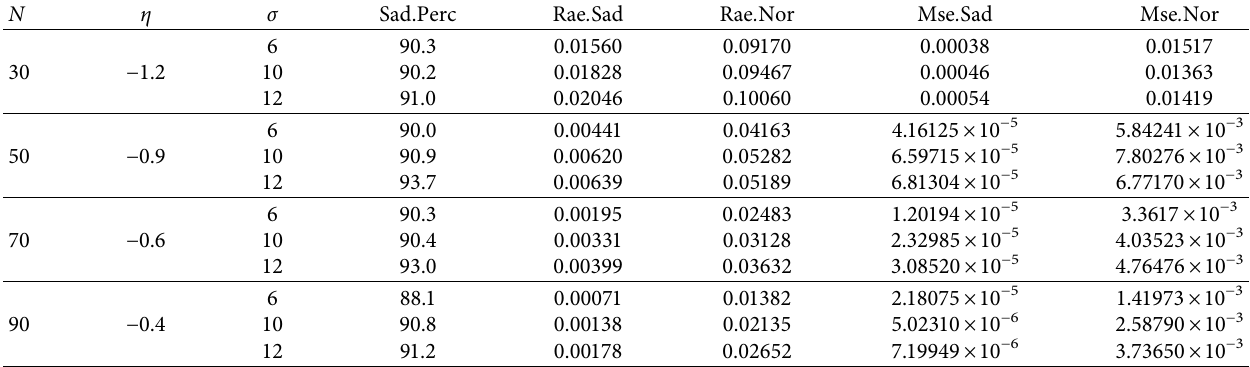
Table 3: Numerical results for the panel count data.